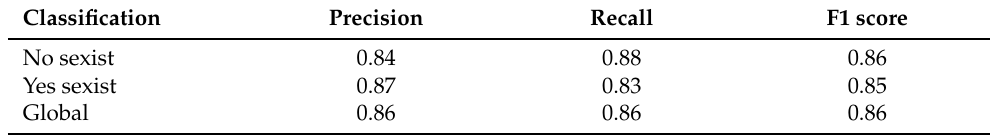
Table 2. Training set: Results for sexist comments, non-sexist comments, and